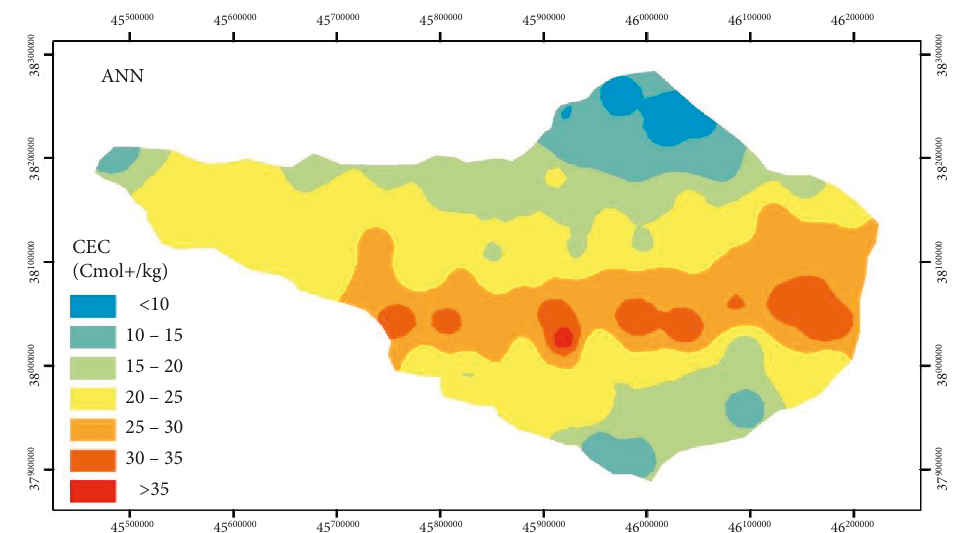
Figure 7: The spatial distribution map of ANN predicted soil CEC (ANN model with 5 inputs).